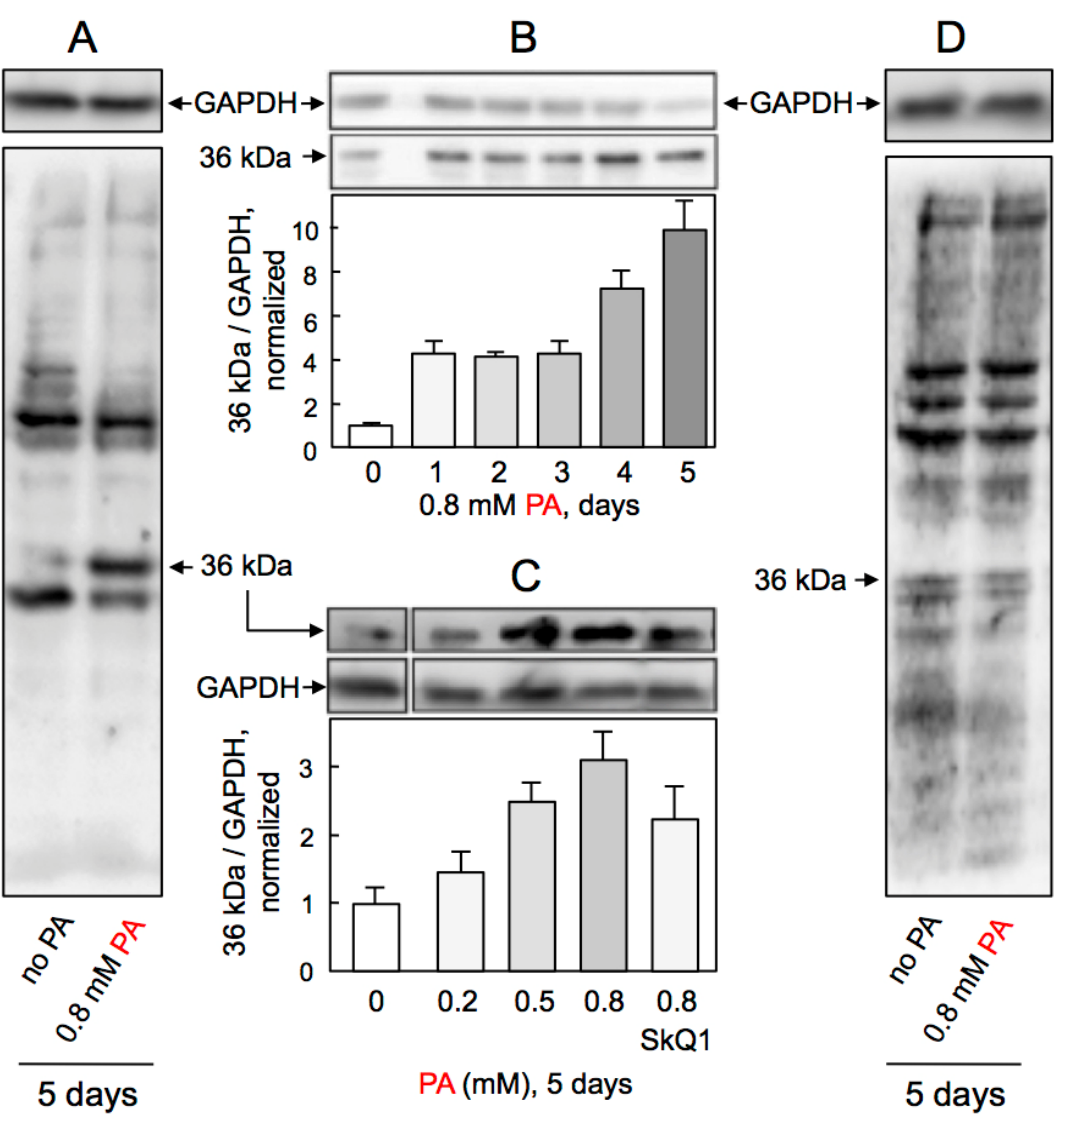
Figure 6. Effects of palmitate and AICAR on protein labeling by MDA in HUVEC. ( A ) Cells were treated by 0.8 mM PA for 5 days and the lysates were probed with antibodies against GAPDH (top) or MDA-labeled proteins (underneath). ( B ) Time-dependent changes in MDA labeling of ~36 kDa protein in response to 0.8 mM PA, n = 2. ( C ) Dose-dependent changes in MDA labeling of ~36 kDa protein at day 5 of cell treatment with PA and the effect SkQ1, n = 2. ( D ) Cells were treated by 0.8 mM PA for 5 days in continuous presence of 1 mM AICAR; the lysates were probed with antibodies against GAPDH (top) or MDA-labeled proteins (underneath).